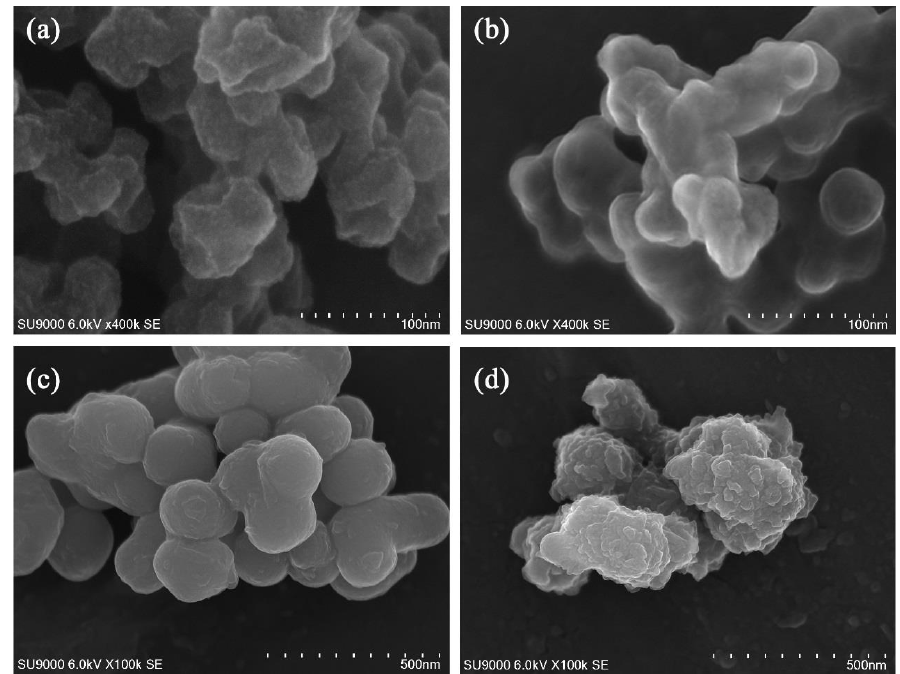
Figure 7. FE-SEM images of ( a ) pristine carbon black; ( b ) HBPEK/CB; ( c ) pristine polyimide nanoparticles; and ( d ) HBPEK/PI [27].